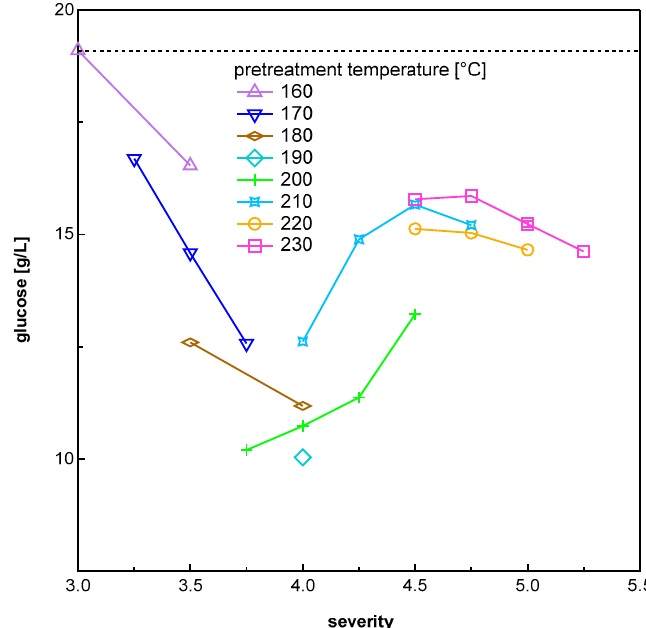
Figure 9. Effect of inhibitors in the steam explosion pretreatment hydrolysates on 24 h glucose yield during enzymatic hydrolysis of Avicel. Shown are the glucose concentrations after 24 h in the enzymatic hydrolysis of Avicel in the presence of different steam explosion prehydrolyzates as a function of pretreatment severity and temperature. The dashed horizontal line denotes the glucose concentration in the control without prehydrolyzate. Energies 2020 , 13 , x FOR PEER REVIEW